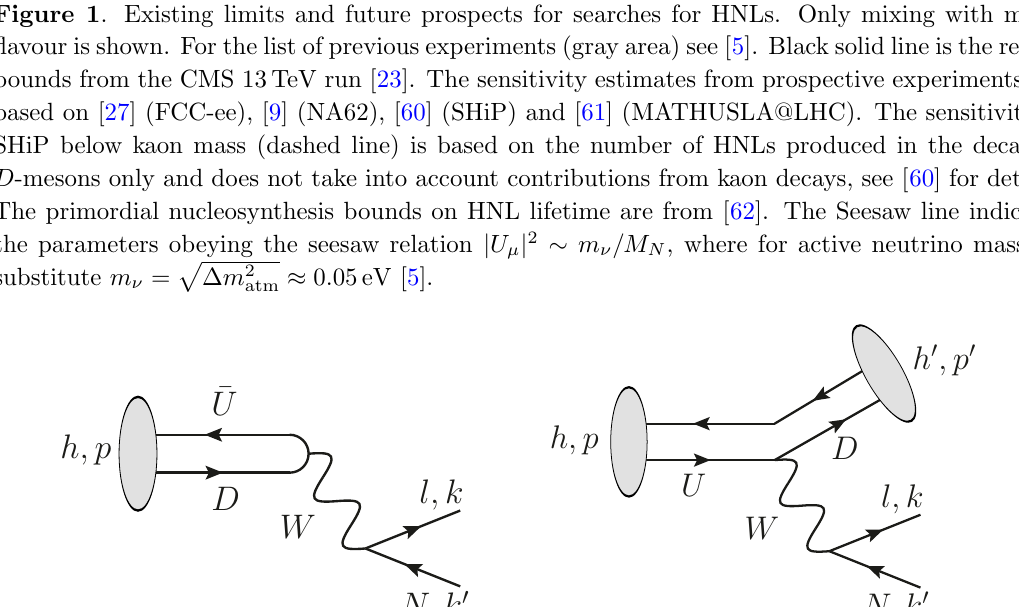
‘ + N (cid:11) ! (cid:25) 0 ‘ + N and K 0 (cid:25) (cid:0) ‘ + N . (cid:11) (cid:11) L=S ! ! (cid:25) (cid:0) ‘ + N due to the helicity (cid:11) L ! decay width. L